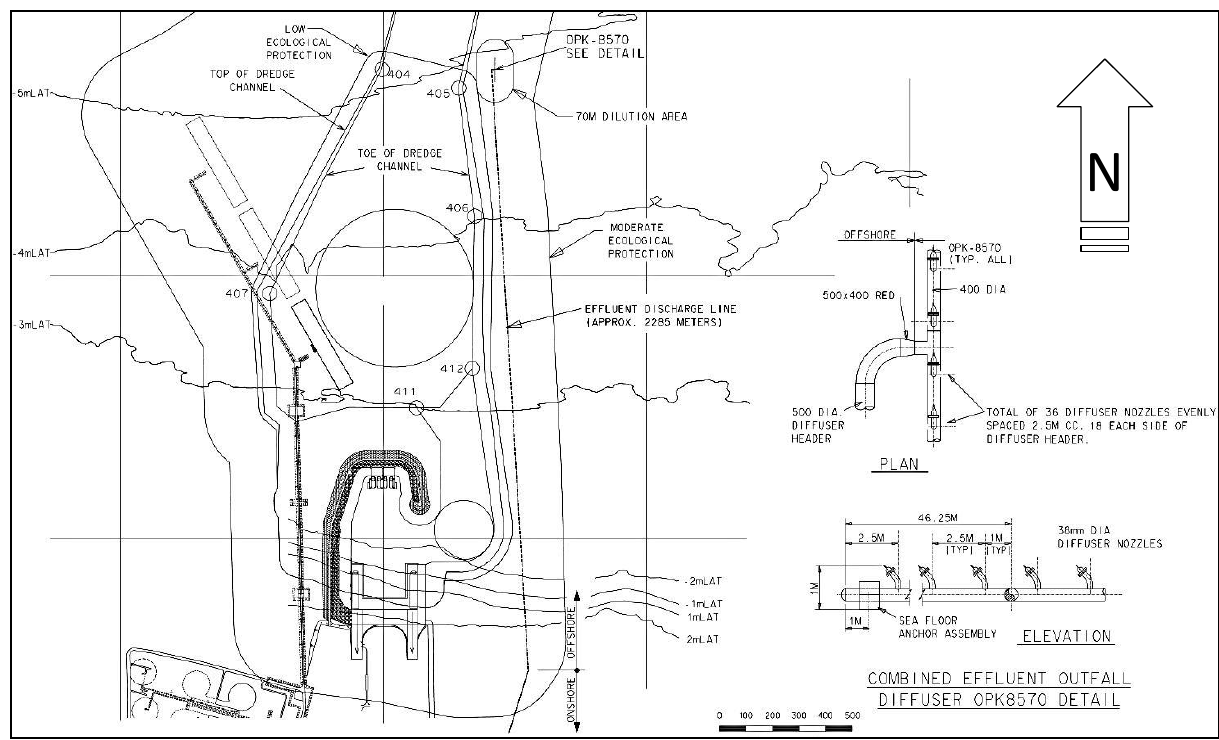
Figure 2. Outfall diffuser location and receiving water